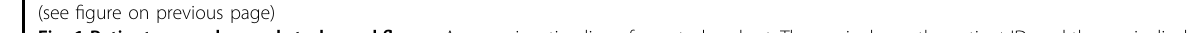
Fig. 1 Patients, samples, and study work fl ow. a An overview timeline of our study cohort. The y -axis shows the patient ID, and the x -axis displays the length of RNA shedding measured from the onset. The 38 patients included 19 with short and 19 with long shedding courses (SC and LC, respectively). Other important information, including the virus nucleic acid test results (sputum or throat swab positive/negative result), gender, severity, comorbidities, etc., are shown in the right panel of the fi gure. The sputum swab was marked as positive from the fi rst to the last continuously positive test during our observation; a persistent negative swab was negative until the end of our observation. The black dots indicate the sampling time for both omics data, while the blue or orange dots represent only the proteomics or metabolomics data, respectively. More details are provided in Supplementary Table S1. b Multi-omics overview involving virological detection based on RT-PCR, an immunological assay based on ELISA and fl ow cytometry, proteomics and metabolomics analyses for 38 COVID-19 patients and 35 control patients. A total of 298 sputum swab samples (from the 38 COVID-19 patients) and 70 sputum swab samples (from the 35 control patients) were used for the SARS-CoV-2 RNA assay across 16 weeks. Immunological measurements were comprised of 190 serum samples for antibodies-mediated detection over nine weeks and 43 whole blood samples for immune cell counting over three weeks. 217 serum samples and 251 peptide samples, including 34 technical replicates, were analyzed by TMT 16-plex-based quantitative proteomics. 193 serum samples and additional 29 quality control samples for metabolomics analysis were acquired with four different methods including three types of RP-UPLC and one of HILIC-UPLC. A total of 945 metabolites were identi fi